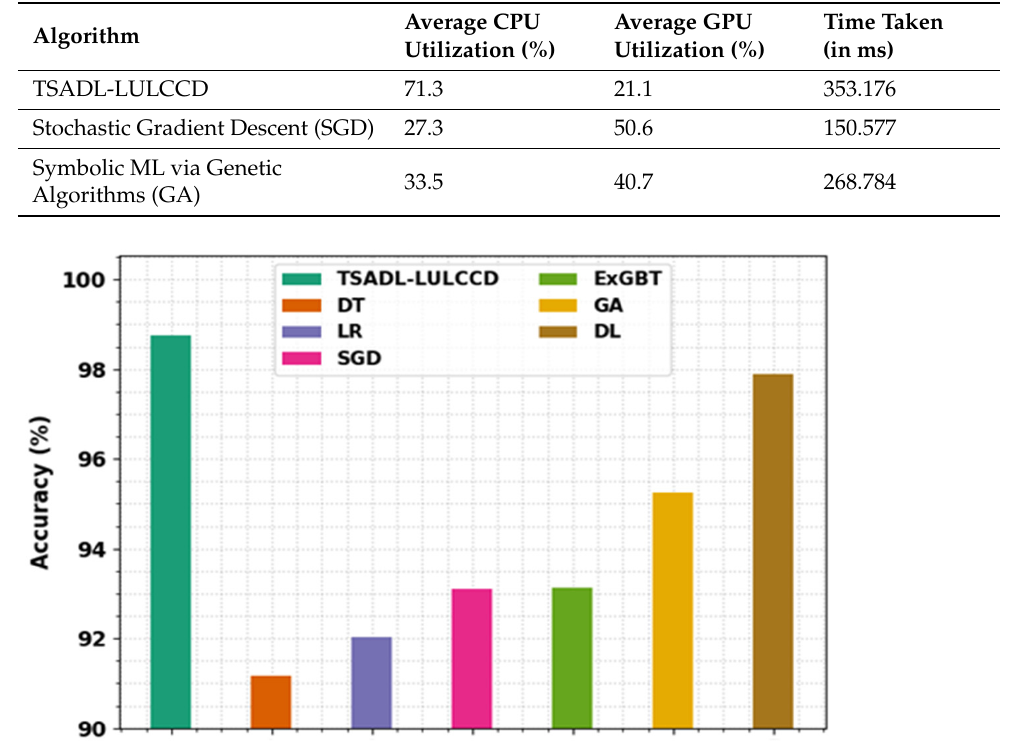
Table 5. Comparative analysis of TSADL-LULCCD approach with other approaches.